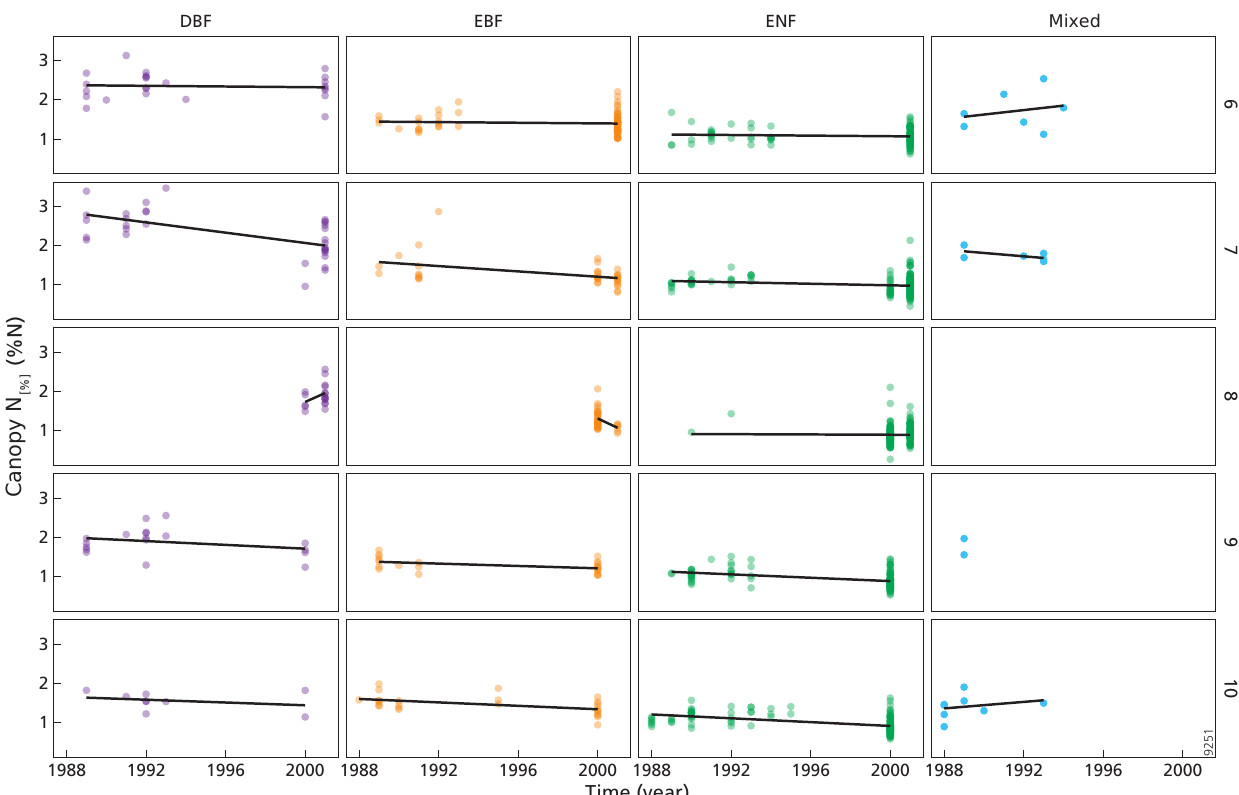
Figure A1. Interannual variation of canopy N [ % ] (%N) for each month included in the analysis. The numbers 6–10 (right side of the figure, row numbers) refer to the months of June, July, August, September and October, respectively. DBF is deciduous broadleaf forest, EBF is evergreen broadleaf forest, ENF is evergreen needleleaf forest, and mixed is mixed forest. Each point represents an observation at a forest plot. Note that the forest plots were not sampled multiple times; hence, the interannual variation encompasses both temporal variation and spatial